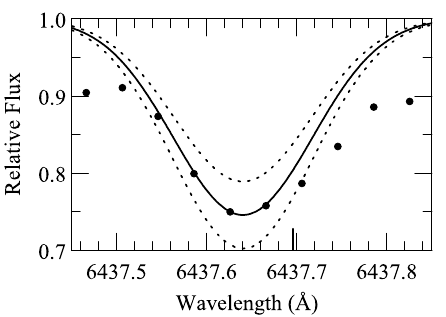
Fig. 22. Eu II line at 6437.6 ˚A in the spec- trum of HD 209621. The synthetic spec- tra are given for the europium abundance log ϵ (Eu) = 0 . 16 ± 0 . 15. The vertical tick at 6437.696 ˚A is the position of CN